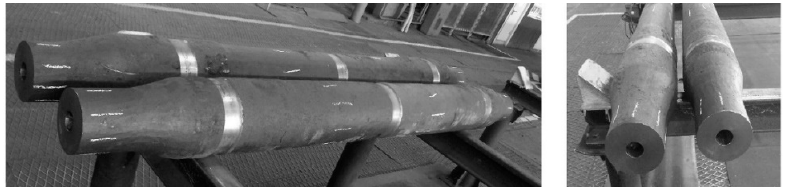
Figure 23. Hollow axle blank [27] (Reprinted with permission from Ref. [27]. 2023, Springer Nature).